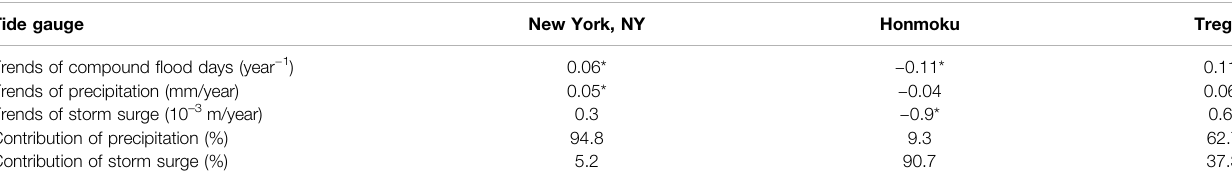
The asterisks (*) denote signi fi cant trends ( α (cid:1)